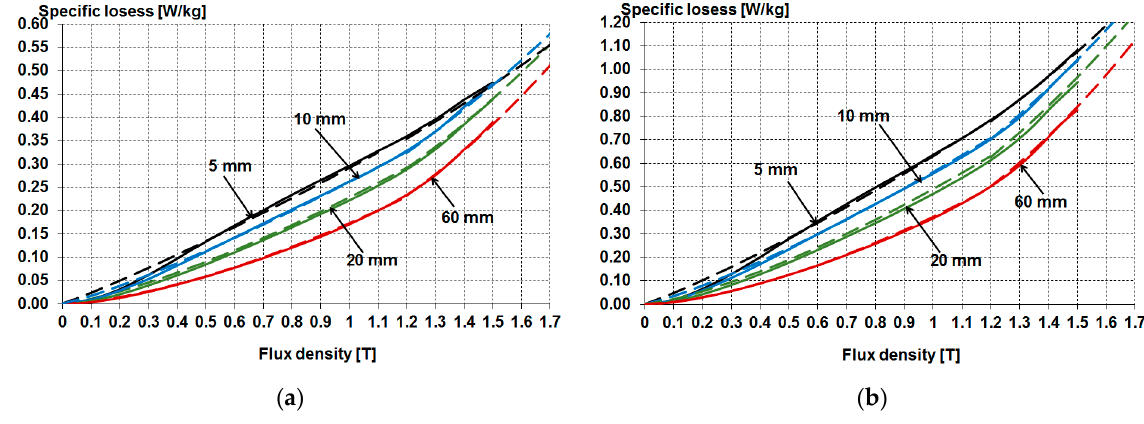
Figure 21. Measured and approximated loss characteristics of the M270-35A sheet for various widths of laser cut sheet samples, at the frequency of 10 Hz ( a ) and 20 Hz ( b ); (measured—solid line, estimated—dashed line).